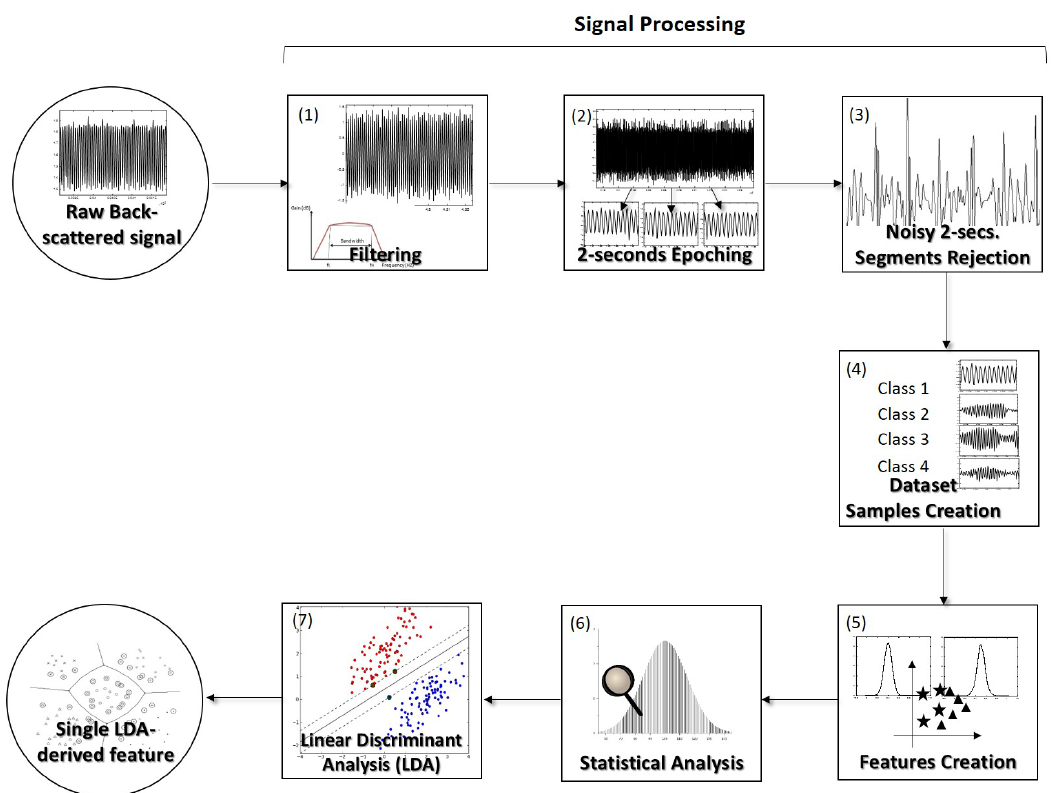
Figure 5. Scheme explaining all the back-scattered signal processing and analysis steps. ( 1 ) At first each 120-s whole acquisition was filtered using a second-order 500 Hz Butterworth high-pass filter. ( 2 ) Then, each entire acquisition corresponding to each particle from each class was split in 2 s signal epochs. ( 3 ) In order to remove the noisy portions, each signal portion was z-scored and